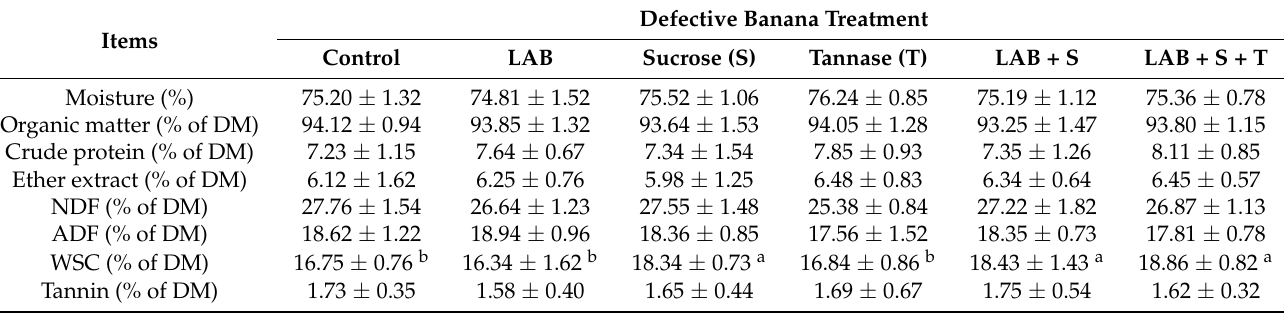
Table 5. Chemical composition of defective banana material before